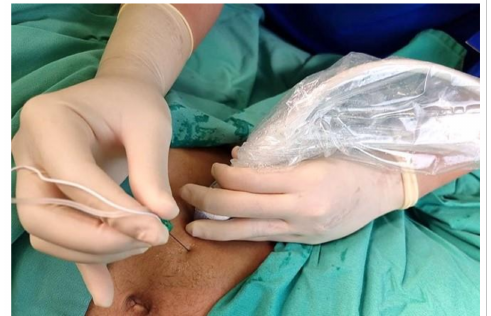
Figure 10. Resting both hands on the patient reduces fatigue and improves beam needle